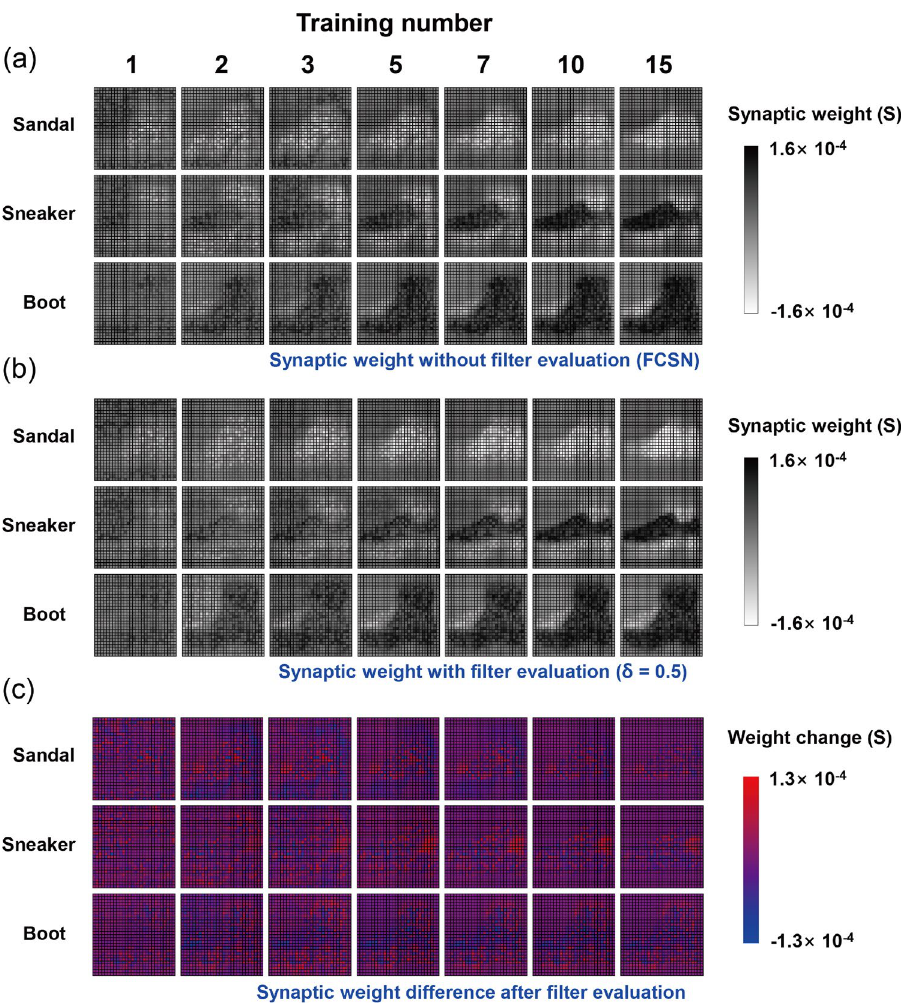
Figure 4. Reshaped 28 × 28 contour images of the synaptic weight for each output class during 15 training numbers ( a ) without and ( b ) with filter evaluation at a δ-value of 0.5 and ( c ) their